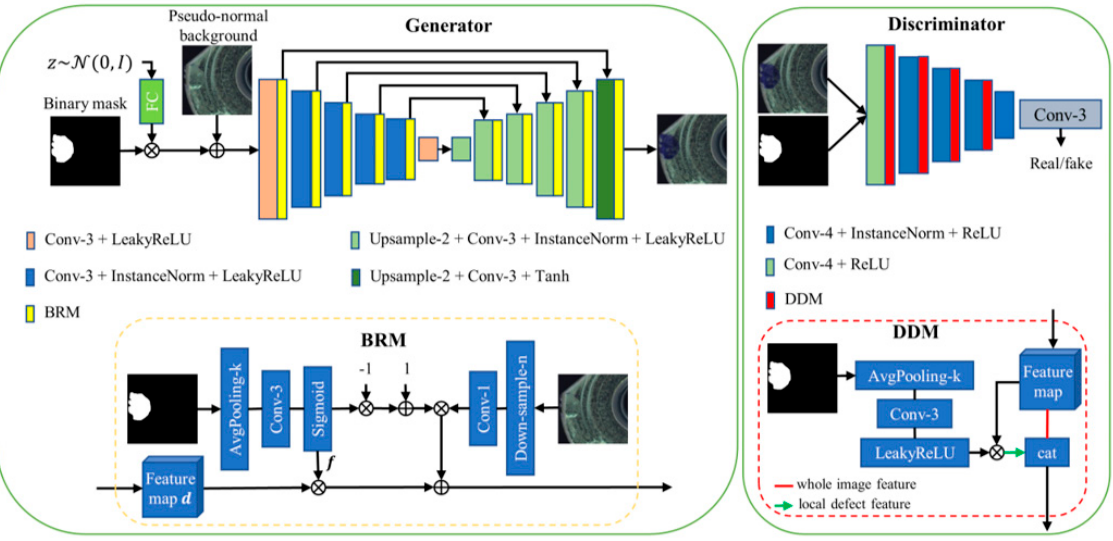
Figure 2. Architectures of MDGAN. Conv-3 means the convolution kernel size is 3 × 3, Upsample-2 means the feature map is upsampled two times. AvgPooling-k means the average pooling kernel size is k × k, which depends on the size of d . cat means the channel-level connection of inputs.